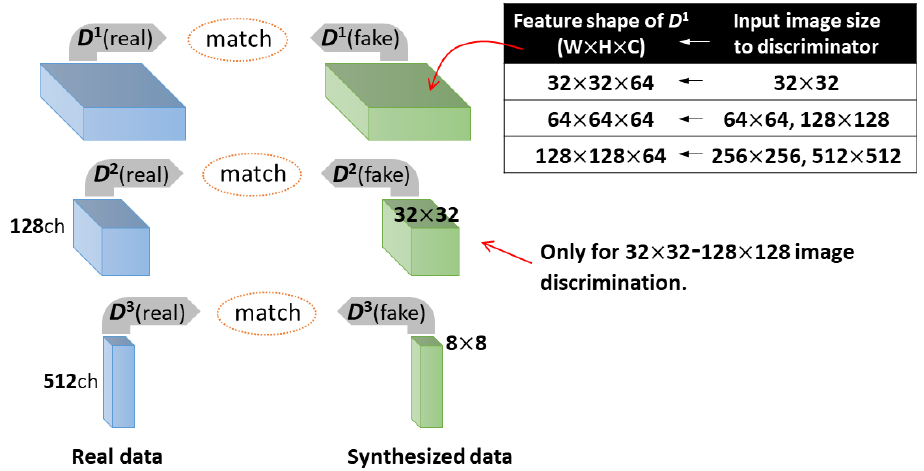
Figure 4. Calculation of feature matching loss ( L FM ) using feature vectors from middle layers of the discriminator. When an image with a resolution ranging from 32 × 32 to 128 × 128 is input into the discriminator, three feature vectors ( D 1 , D 2 , D 3 ) are used to calculate L FM . The shape of D 1 depends on the input image size. When a 256 × 256 or 512 × 512 image is input into the discriminator, L FM is calculated from two vectors with shape 128 × 128 × 64 and 8 × 8 × 512,